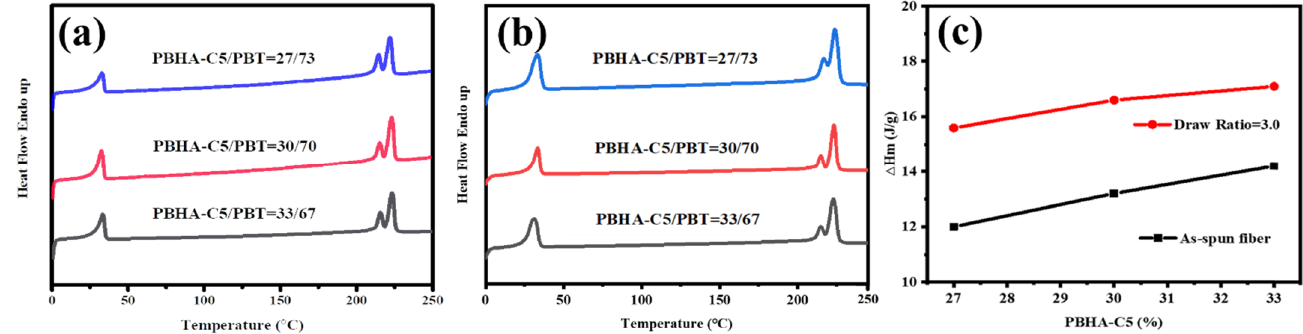
Figure 13. Plots of the surface temperature change in samples as a function of time.